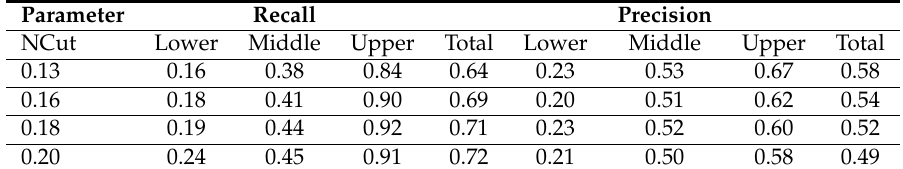
Table 7. Sensitivity analysis for tree detection in reference areas. HTO . Total number of trees is 1596.